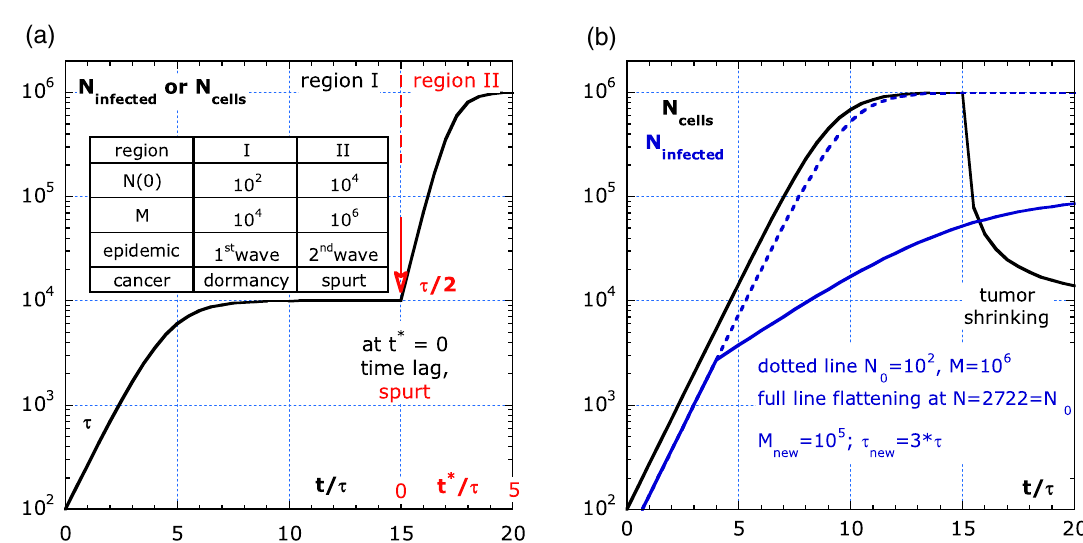
Figure 4. Exponential growth of cancer cells. ( a ) Variability in cancer due to an increase in risk with age of four individuals belonging to groups indicated by: H, high; L, low; P, predisposition; D, dose. The values for predisposition are: τ 0 = 5 y (HP), τ 0 = 20 y (LP). The effect of age and absorbed dose is reflected by the values: b = − 0.01 y −1 (HD), and b = − 0.005 y −1 (LD). ( b ) Exponential growth in cancer cells after crossing the risk-threshold illustrated in ( a ).